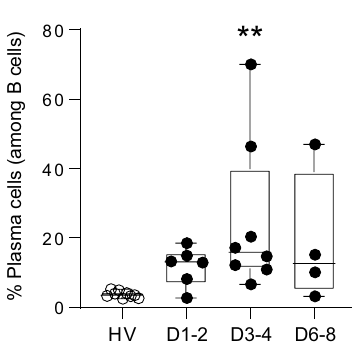
Fig. 1 Plasma cells expansion in septic patients. Percentages of plasma cells (CD19 low FS high cells—see Additional file 1: methods for gating strategy) among total CD19 + B lymphocytes were assessed by flow cytometry on peripheral whole blood in healthy volunteers (HV, n 9) and septic patients ( n 9) sampled at = = day 1 or 2 (D1–2, n 6), day 3 or 4 (D3–4, n 8) and day 6, 7 or 8 (D6–8, n 4) after the onset of septic shock. = = = Data are represented as Tukey box‑plots and individual values. ** p < 0.005 compared to healthy